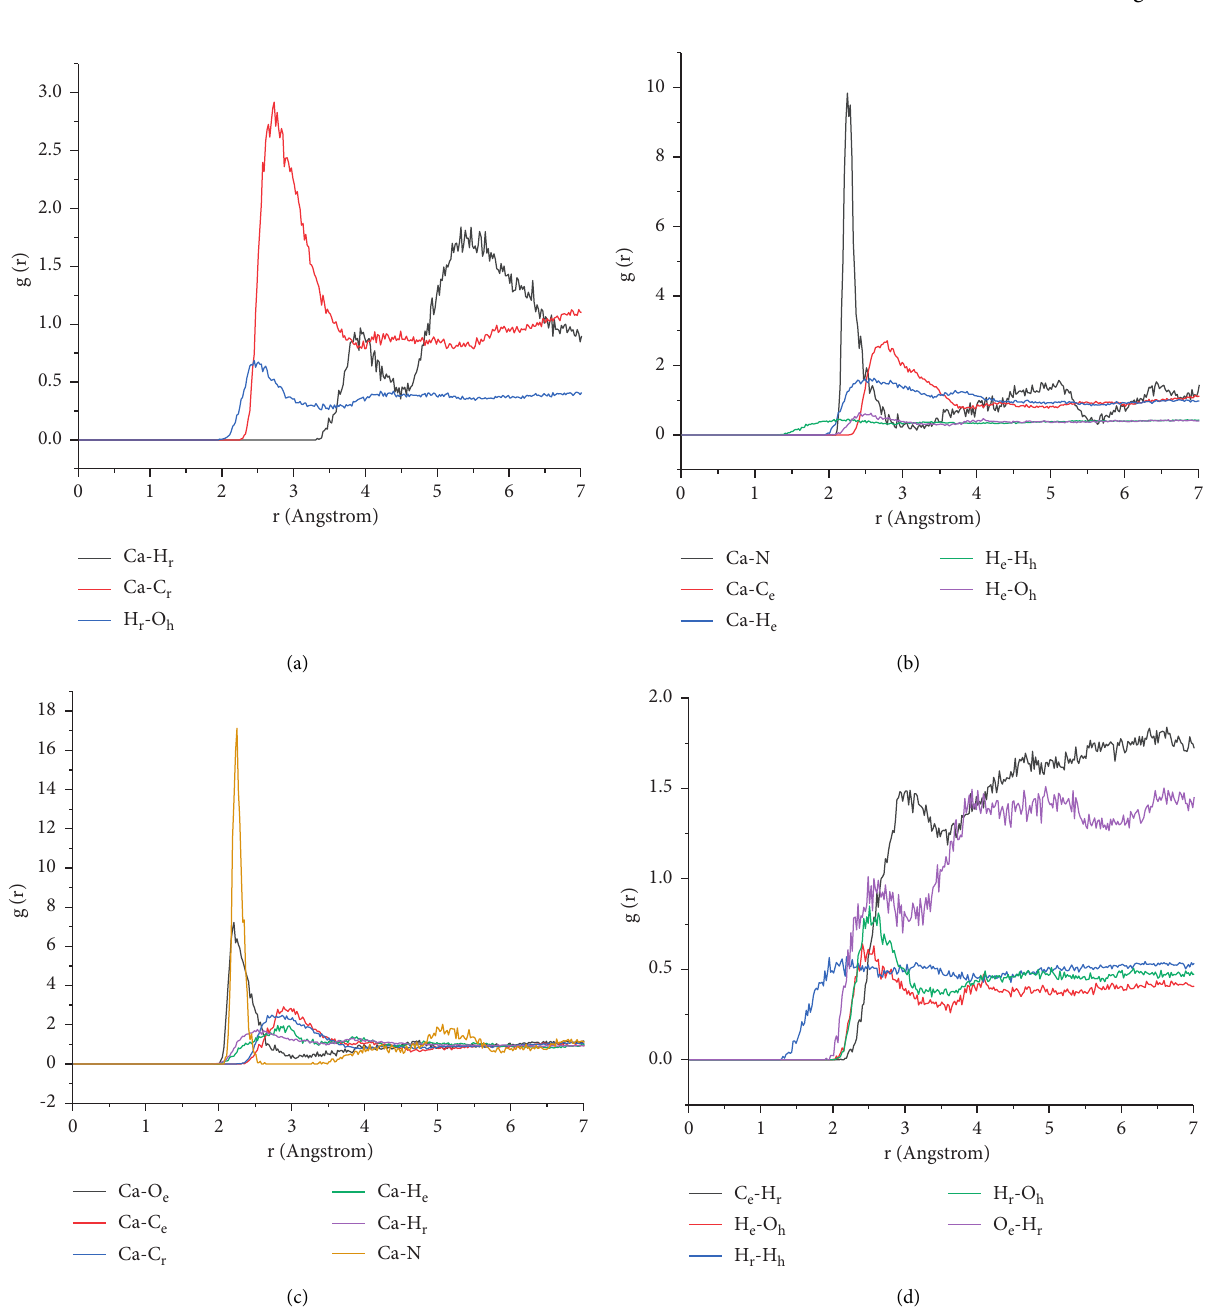
Figure 5: RDF of C-S-H and atoms in the polymers (a) RH/C-S-H RDF, (b) EP/C-S-H RDF, and (c) RH/EP/C-S-H